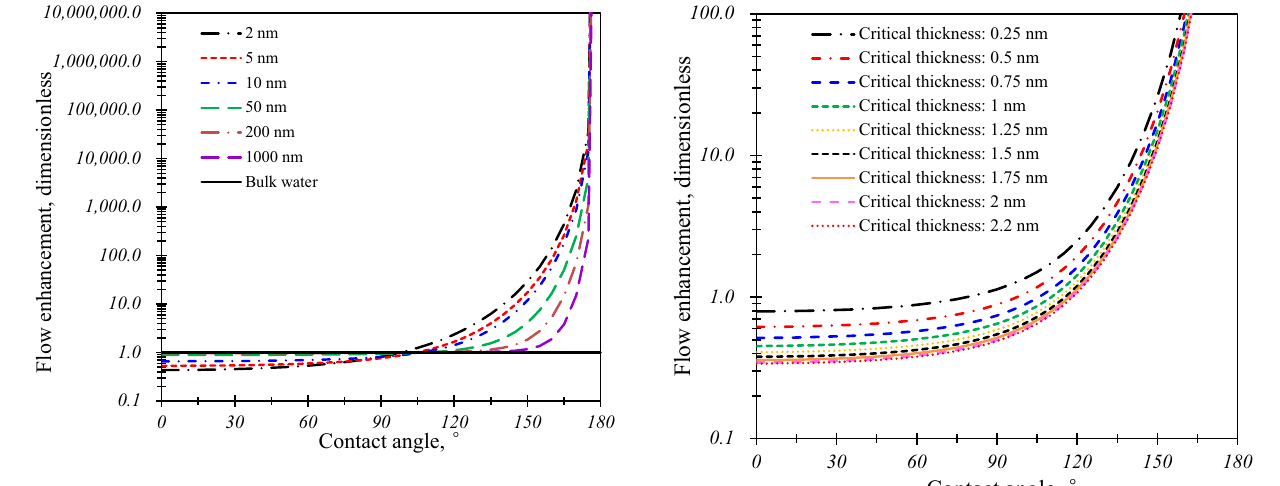
Fig. 2 Relationship between flow enhancement and contact angle under various diameters of nanopores (the reader can find the improvement of this figure from Wu et al.’s work (2017): the curves are moved in the horizontal direction due to calculation equation improvement)